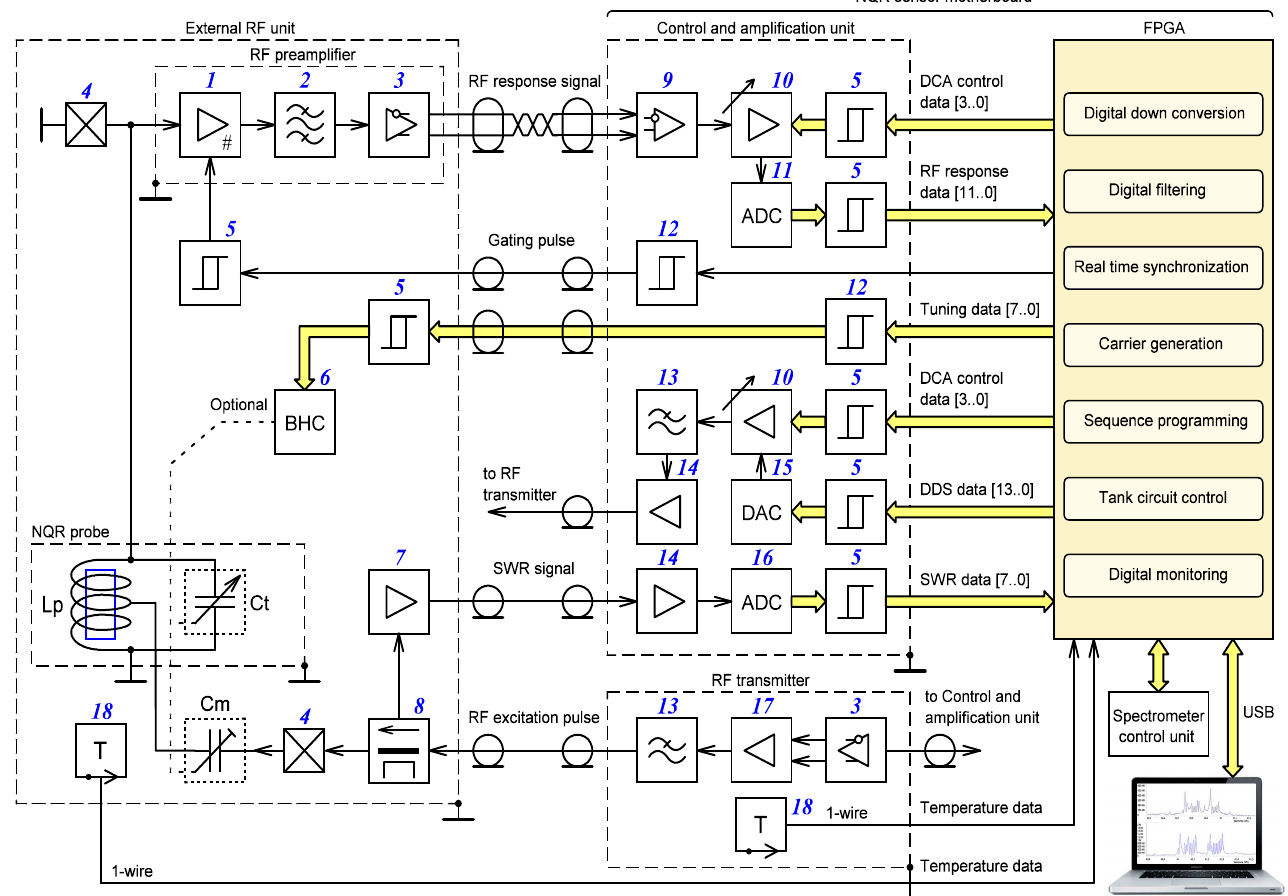
Figure 1. Block diagram of an NQR sensor: (1) gated amplifier; (2) bandpass filter; (3) differential driver; (4) diode limiter; (5) non-inverting buffer; (6) binary–hexadecimal converter; (7) driver amplifier; (8) reflection measurement circuit; (9) differential buffer; (10) digital controlled amplifier; (11) 12 bit analog to digital converter; (12) non-inverting driver; (13) low-pass filter; (14) buffer amplifier; (15) 14 bit digital to analog converter; (16) 8 bit analog to digital converter; (17) radio frequency power amplifier; (18) temperature sensor; (Cm) matching capacitor; ( С t) tuning capacitor; (Lp) probe coil.